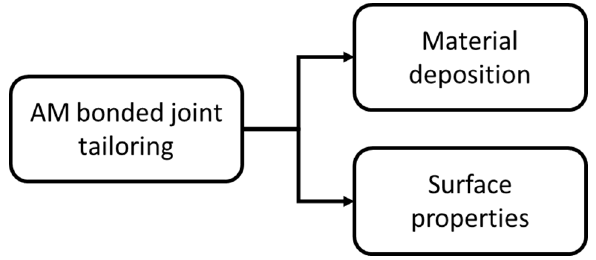
Figure 1. Macro sorting of the design strategies for additive manufacturing (AM) bonded joints.